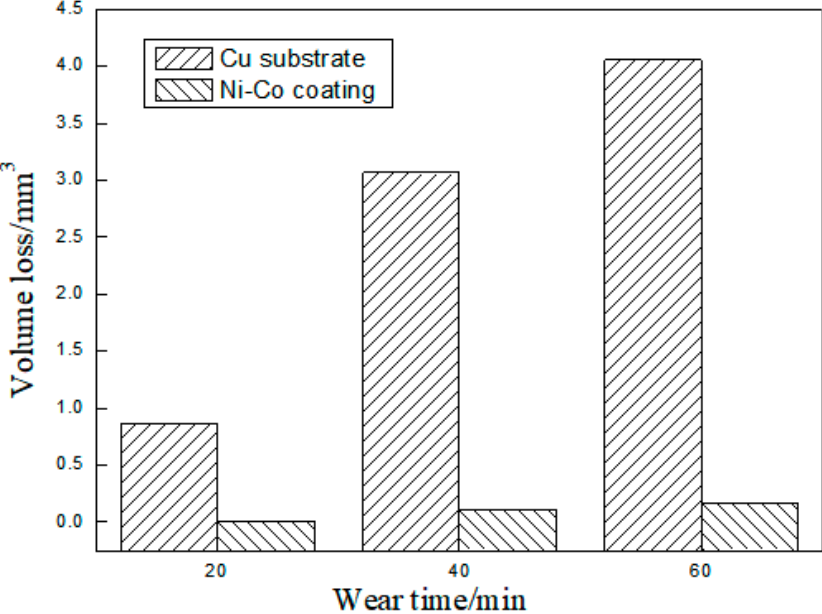
Figure 8. Wear volume of the copper substrate and Ni–Co coating along with different times.